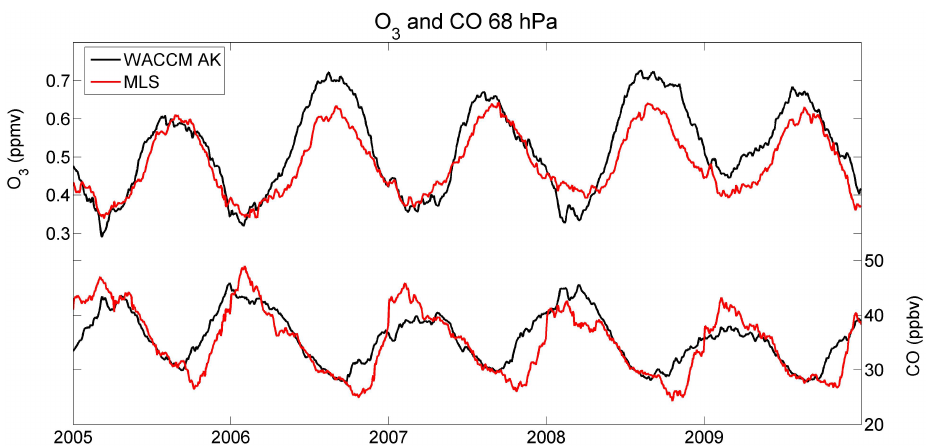
Fig. 2. Time series of zonal mean 68hPa ozone and CO from MLS observations (red lines) and from WACCM (calculated using MLS averaging kernels, black lines). Results are averaged over 18 ◦ S–18 ◦ N for WACCM and 18.75 ◦ S–18.75 ◦ N for MLS.